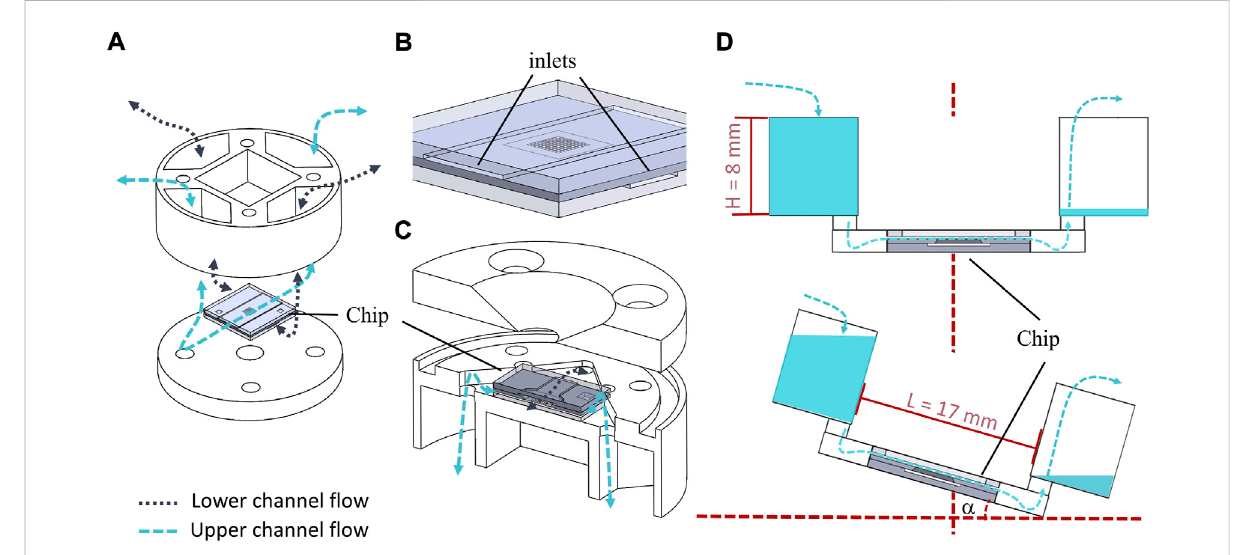
FIGURE 5 (A) Explosion drawing of the chip holder with gravity driven fl uid supply system where the dashed lines indicate how the open media reservoirs areconnectedto thechip compartments. (B) Zoomed 3Ddrawing oftheOOCsystem with largeinletson theedge. (C) Explosiondrawingproviding view from the bottom into the half-cut holder with chip. The bi-directional fl ow stream is sketched with dashed-lines. (D) Schematic illustration of the gravity driven pumping with rocking angle α facilitated by the holder with critical geometries L and